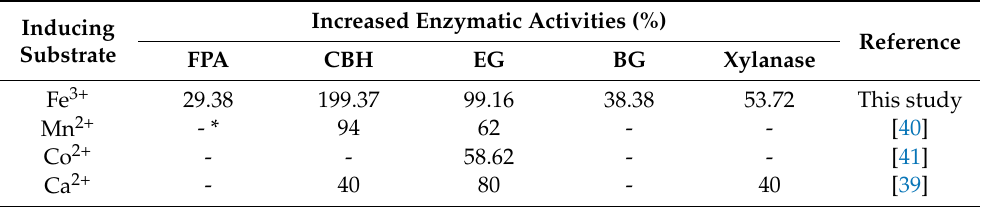
Table 2. Comparison of enzyme activities secreted by fungi co-supplied with various metals.